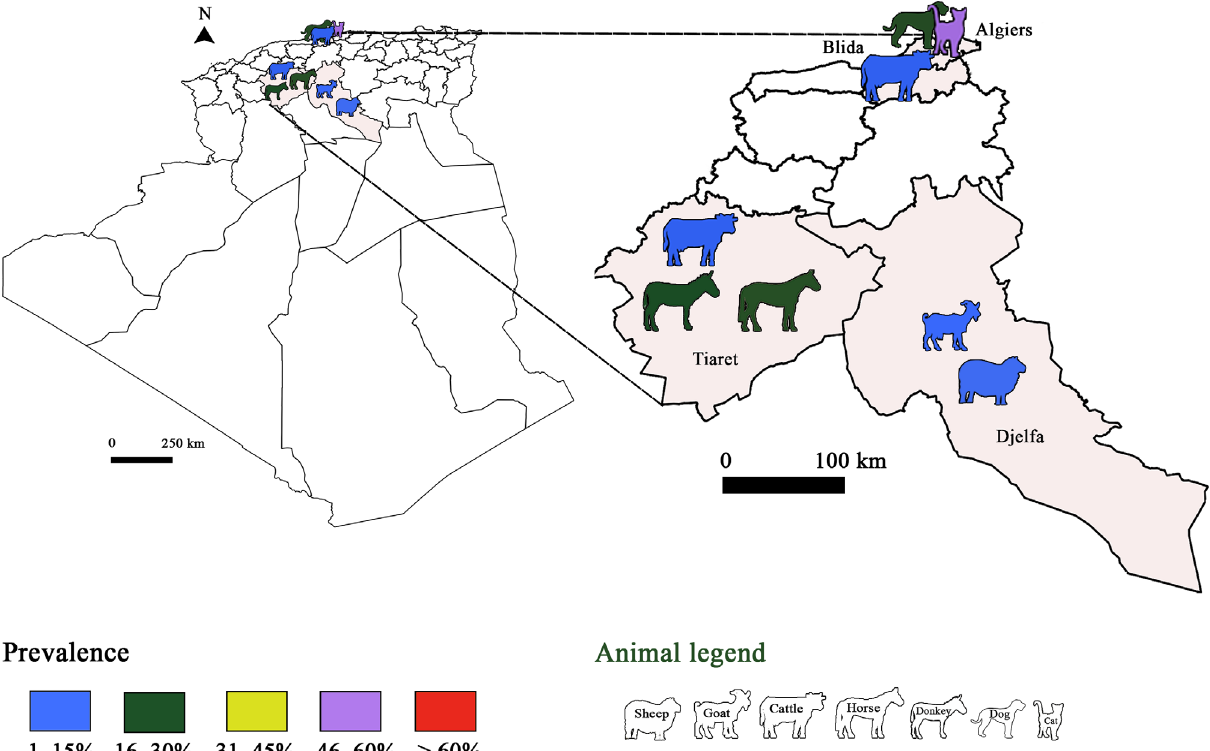
Figure 2. Prevalence of Toxoplasma gondii infection in Algeria: Animal toxoplasmosis,